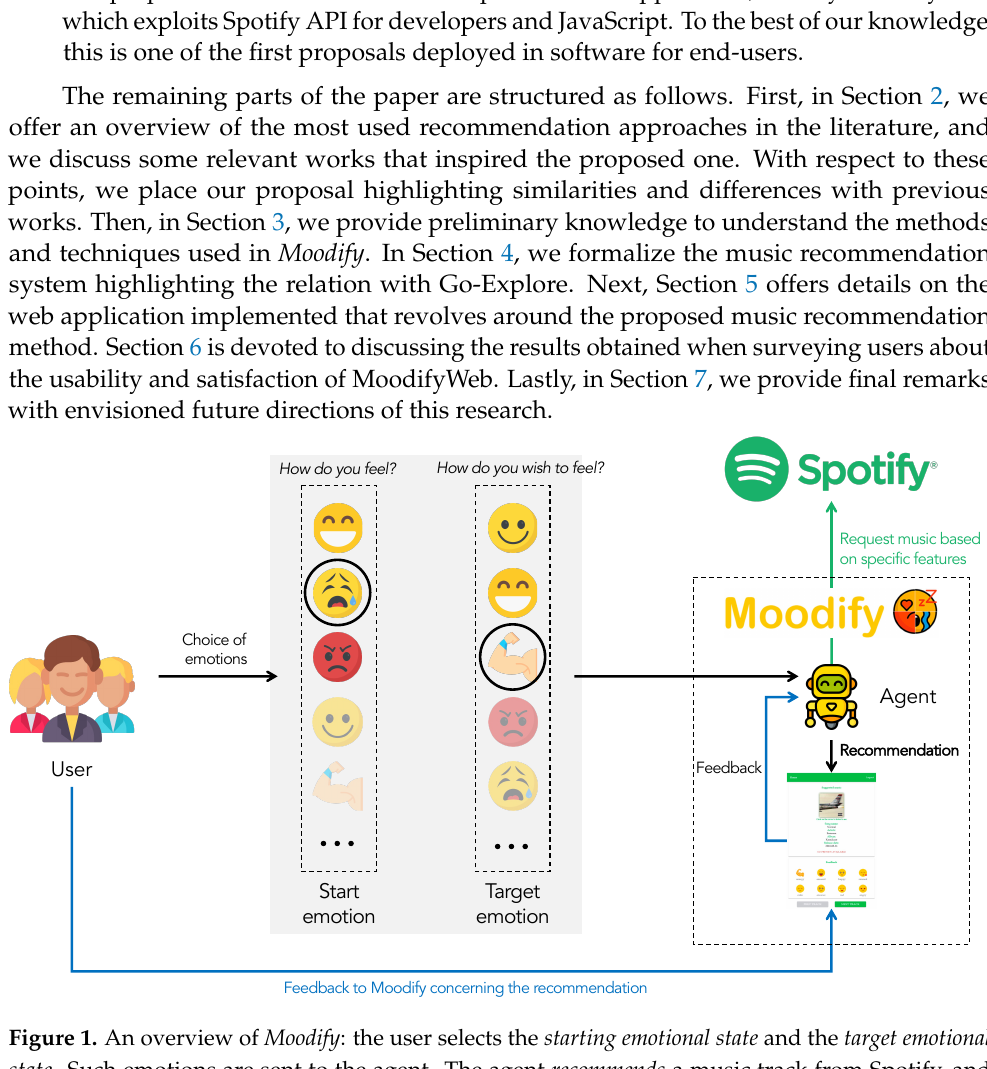
Figure 1. An overview of Moodify : the user selects the starting emotional state and the target emotional state . Such emotions are sent to the agent. The agent recommends a music track from Spotify, and expresses feedback through MoodifyWeb . Such feedback is, in turn, provided to the agent for refining the recommendation